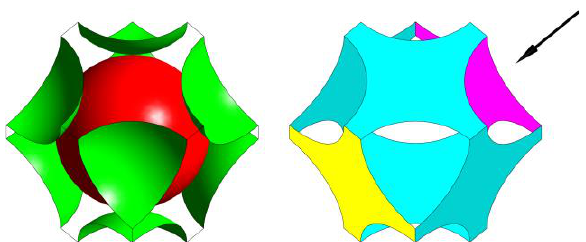
Fig. 5. Boundary conditions.